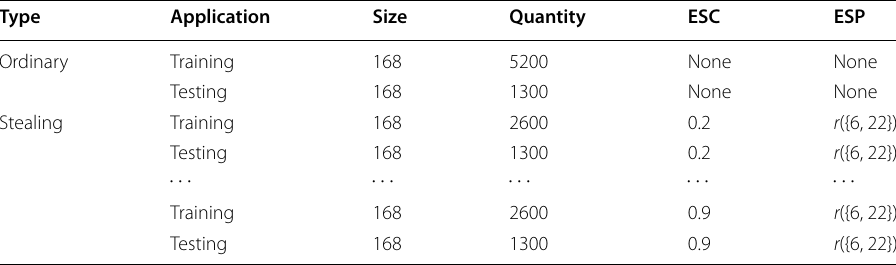
Table 1 Hybrid dataset composed of real electricity data and specific electricity stealing data